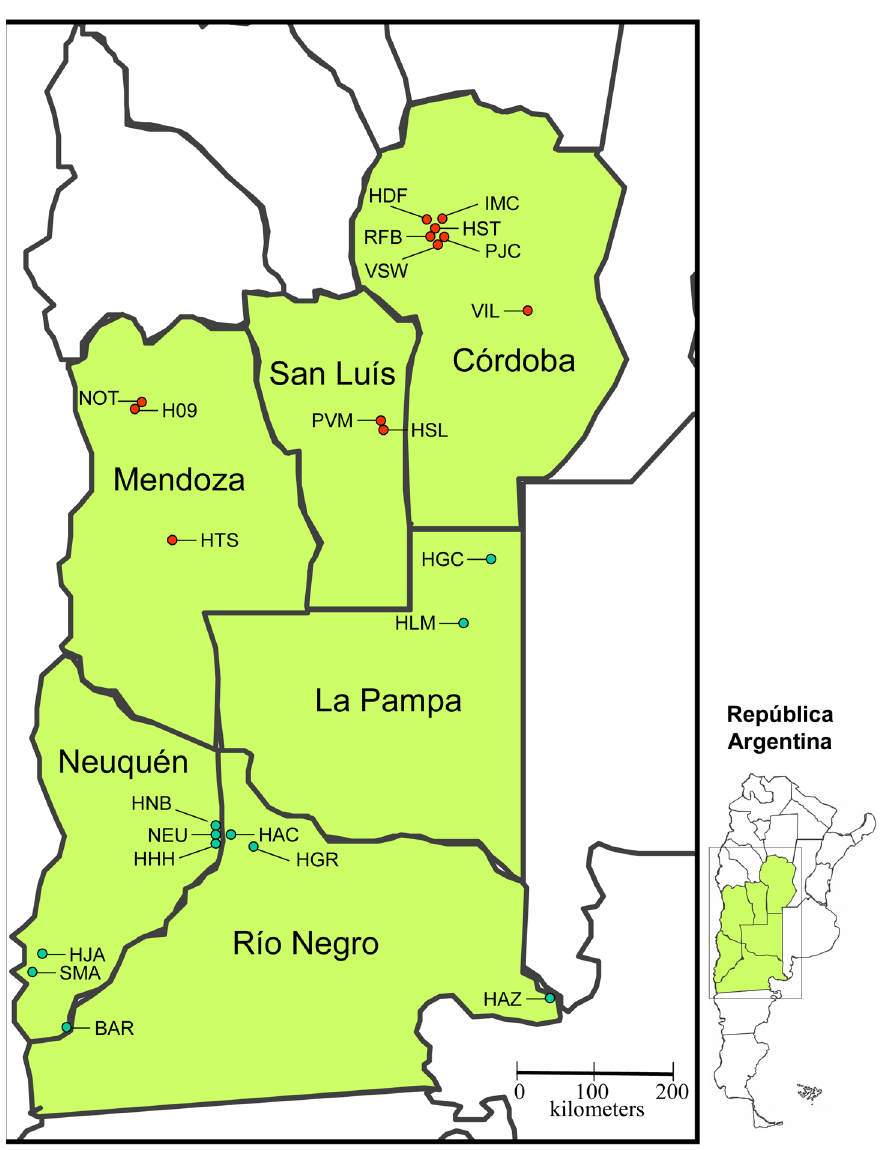
Figure 1. Geographic distribution of laboratories including in this study. The 23 participating laboratories of six provinces of Argentina are indicated with a green circle : 11 hospitals in the three contiguous provinces HAC, BAR, HAZ and HGR from Rı´o Negro province (RN); HLM, HGC from La Pampa province (LP); HHH, NEU, HJA, HNB, SMA from Neuque´n province (NEU); and with a red circle: 12 additional hospitals from the three additional contiguous provinces: PJC, RFB, IMC, HST, VIL, HDF and VSW from Co´rdoba province; PVM and HSL of San Luis province and H09, NOT and HTS from Mendoza province.